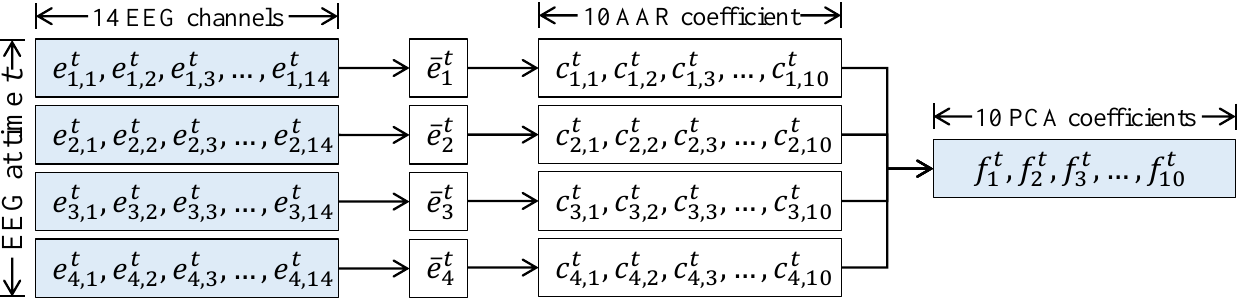
Figure 4. Overall process of data preprocessing